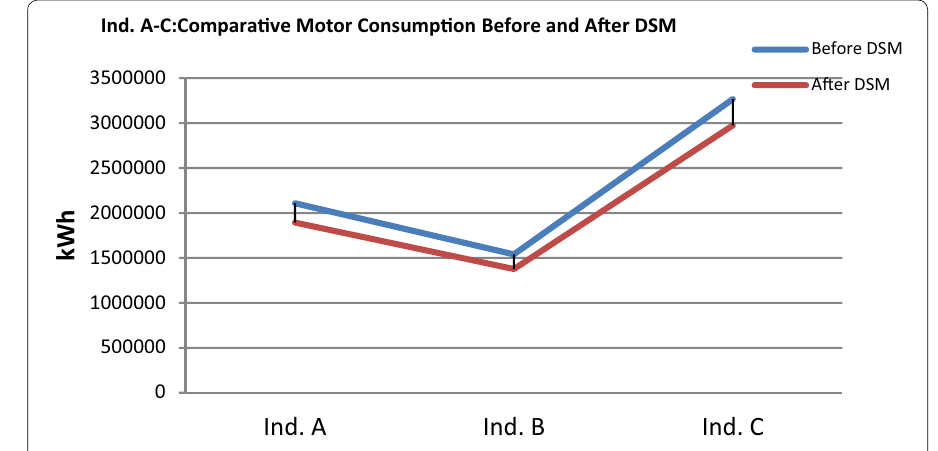
Fig. 4 Comparative of energy consumption by motors before and after application of DSM